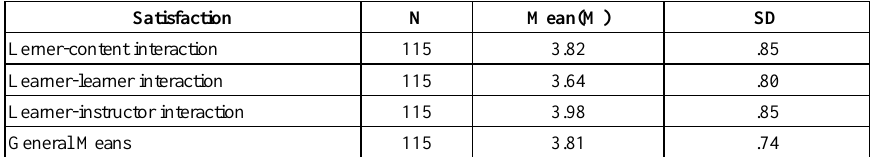
Table 3. Mean scores of participants’ satisfaction on types of interaction